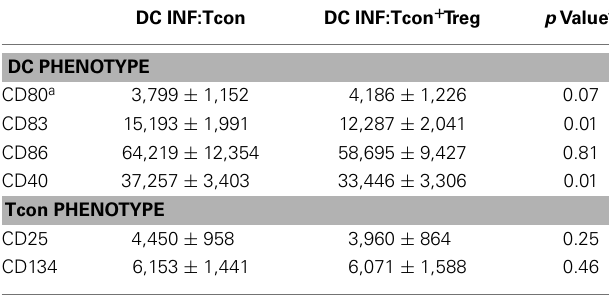
FIGURE 4 | RegulatoryT cells decrease actin polymerization at the immunological synapse in DC:Tcon clusters .The actin polymerization at the IS was quantified using interface mask. Intensity of actin within the interface was calculated, as well as that in the overall DC cluster. Data are expressed as a ratio of actin in the IS divided by the total actin intensity in the